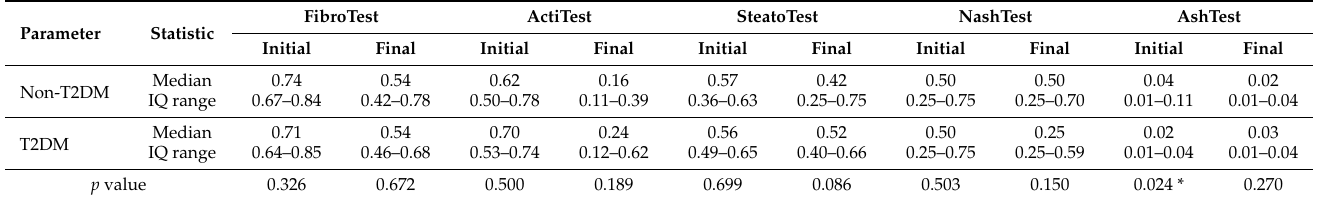
Table 2. FibroMax parameters in non-T2DM patients vs. in T2DM patients both before DAA treatment (initial) and 3 years after DAA treatment